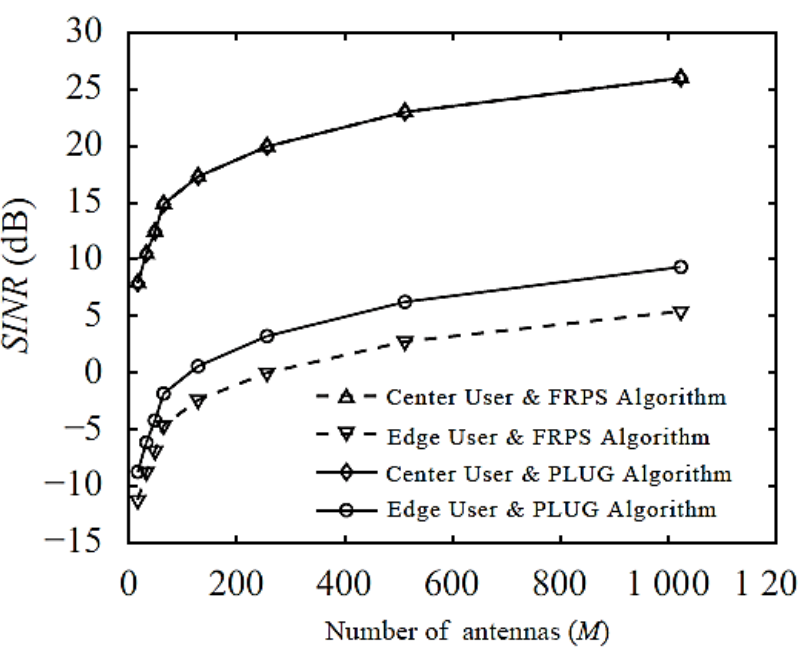
Figure 9. NMSE comparison of FRPS and PLUG Algorithms.